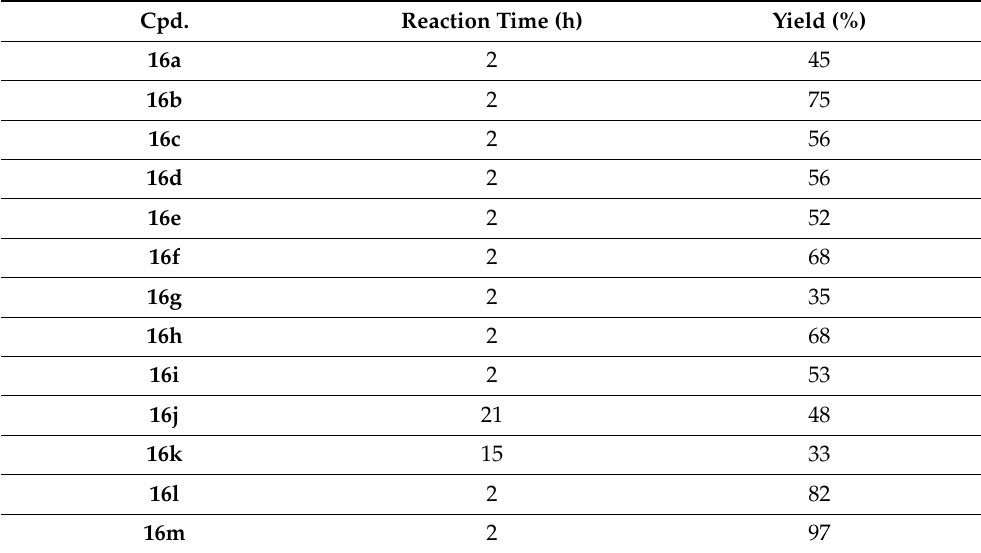
Table 1. Reaction times to synthesize cpds. 16a – 16m by reductive amination with STABH, and their